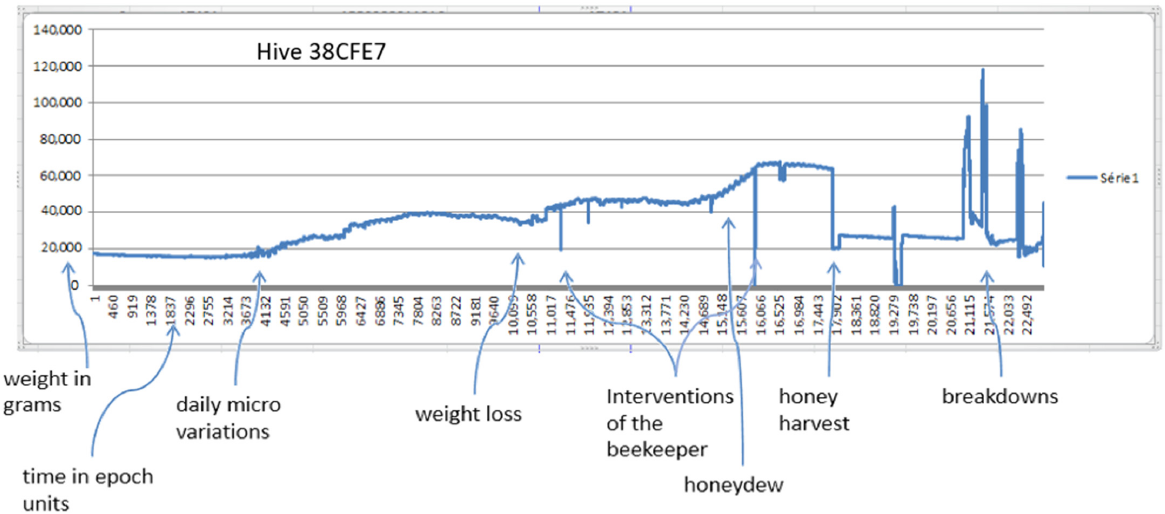
Figure 4. Detected Patterns.